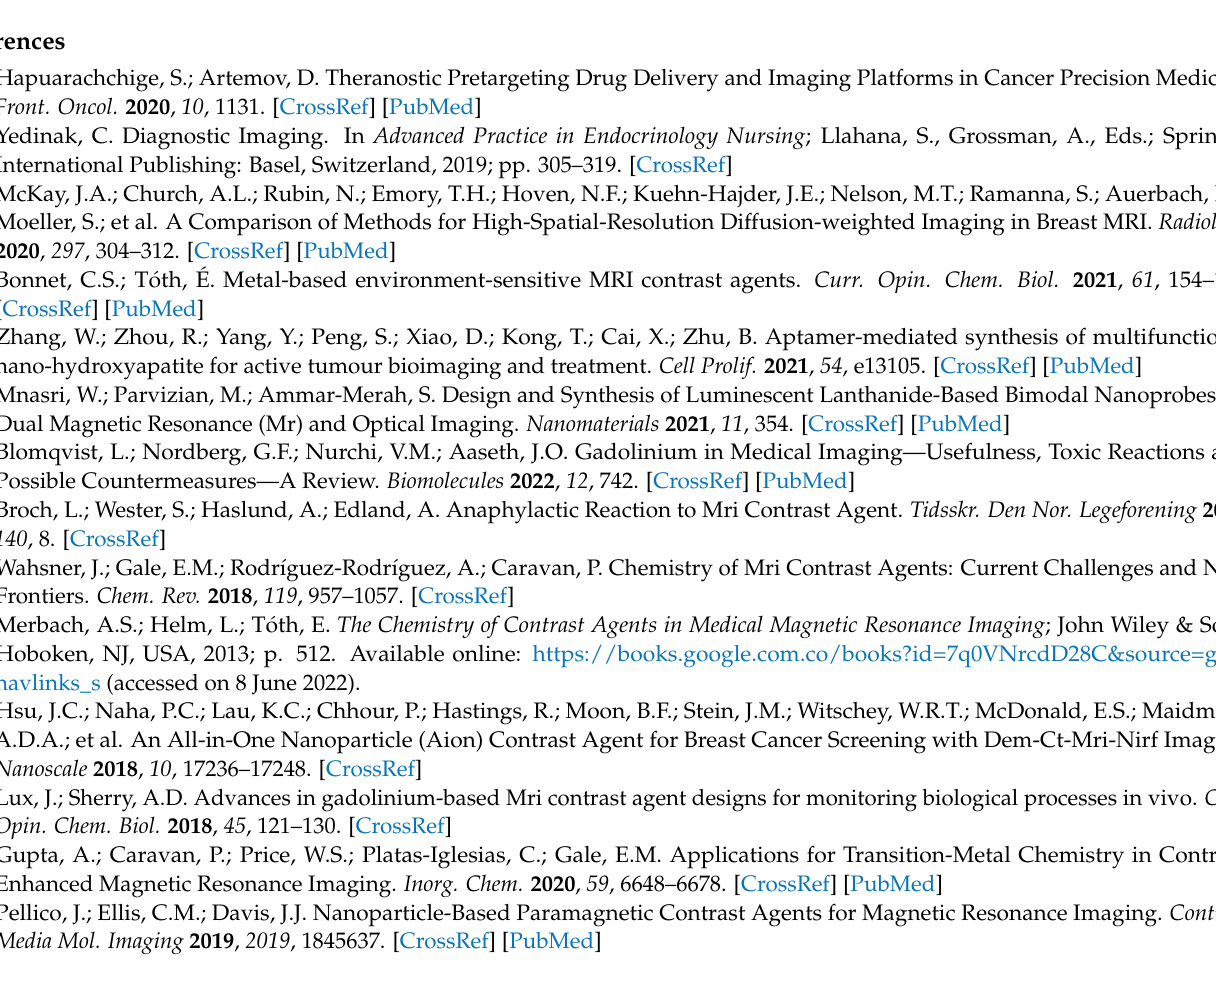
Figure S1: Mass fragments Chromatogram S8 Compound